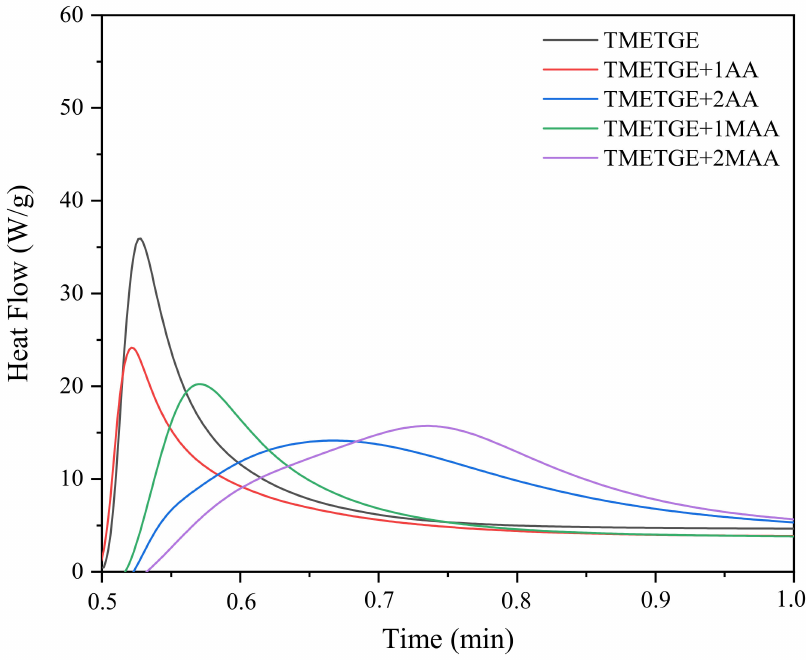
Figure 9. Photo-DSC exotherms for the photopolymerization of epoxy (meth)acrylate formulations with cationic photoinitiator.